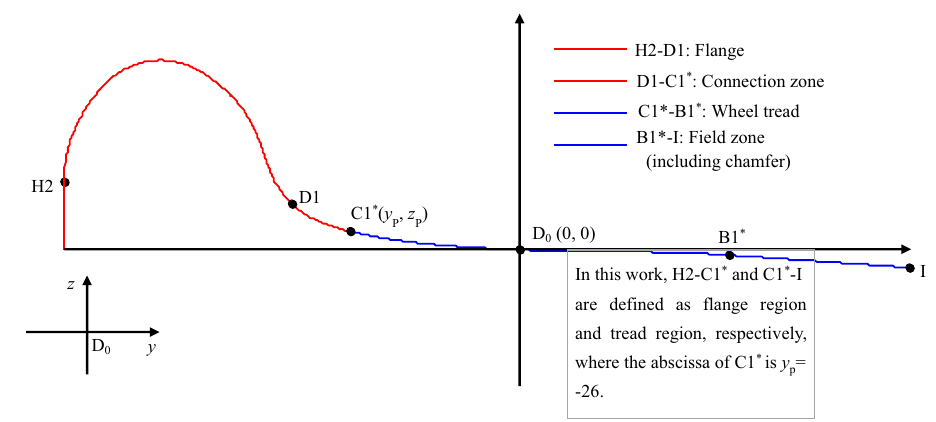
Fig. 10 Definition of the flange region and tread region (see EN